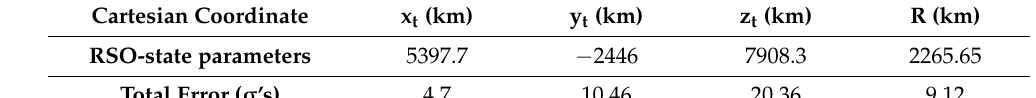
Table 5. RSO position estimates and errors.